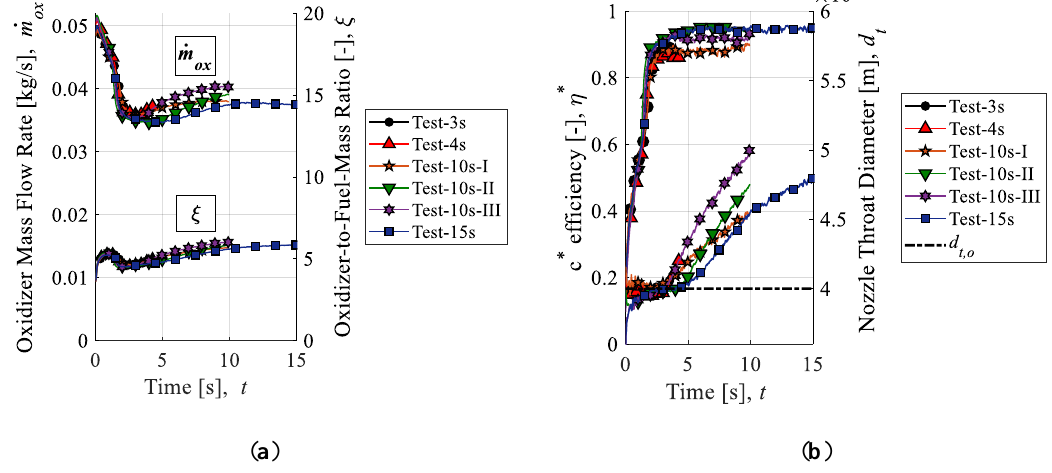
Figure 10. The NTRT+ analysis ( a ) propellant flow rates; ( b ) throat erosion and efficiency histories. 481 Figure 10. The NTRT + analysis ( a ) propellant flow rates; ( b ) throat erosion and e ffi ciency